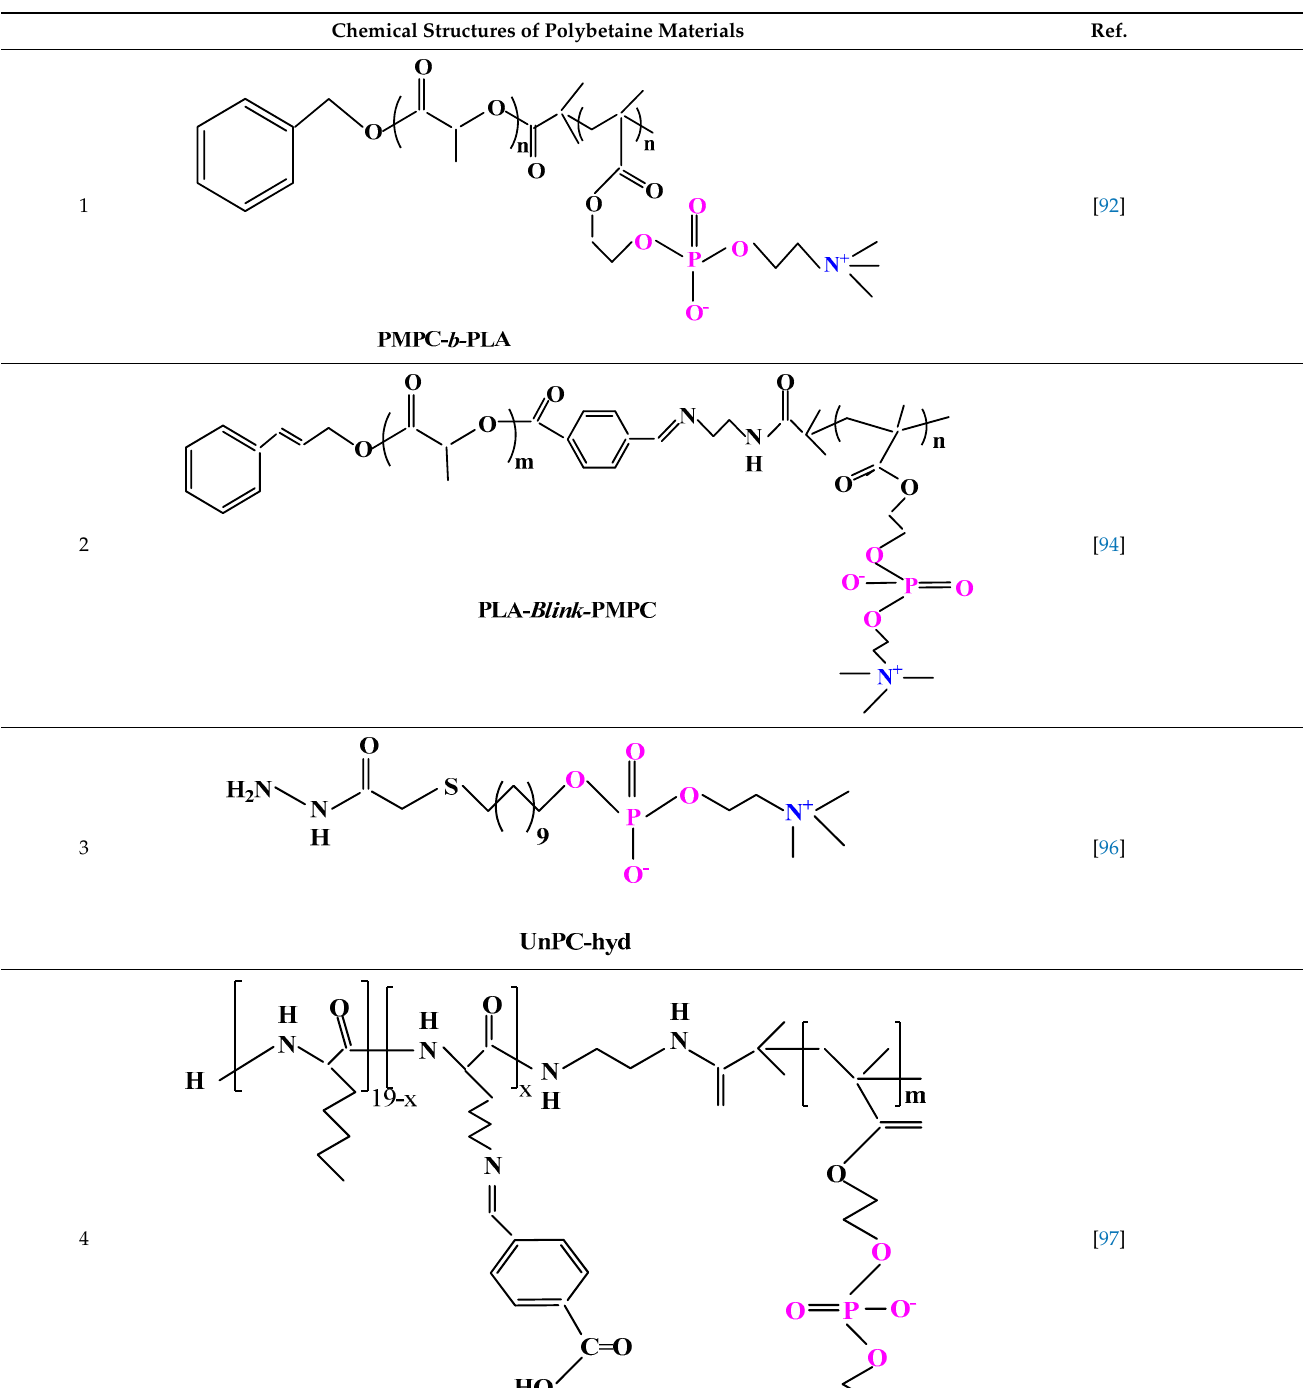
Table 3. Chemical structures of polybetaine materials used in cancer therapy. Chemical Structures of Polybetaine Materials Ref.